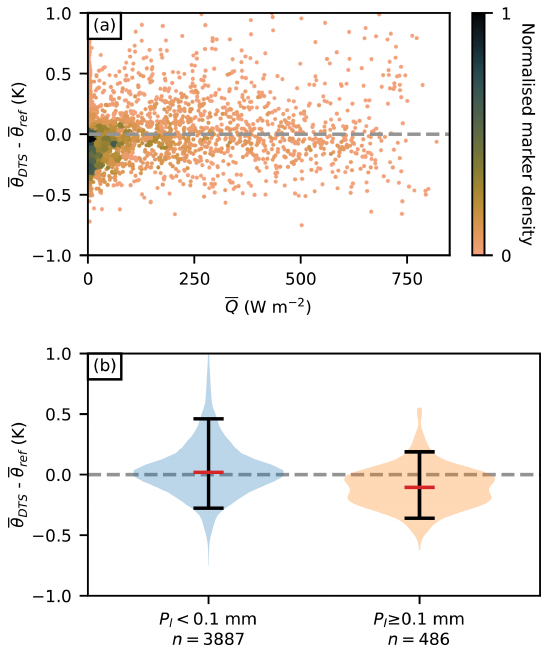
Figure 3. Deviations of the DTS-estimated temperature (a) variance and (b) skewness from the corresponding estimates using the sonic anemometer data. The solid red lines are the root-mean-square- deviations (RMSD) computed for 10 equally sized bins (bin centres are marked with × symbols). The dashed blue lines are the corre- sponding 95th percentiles for each